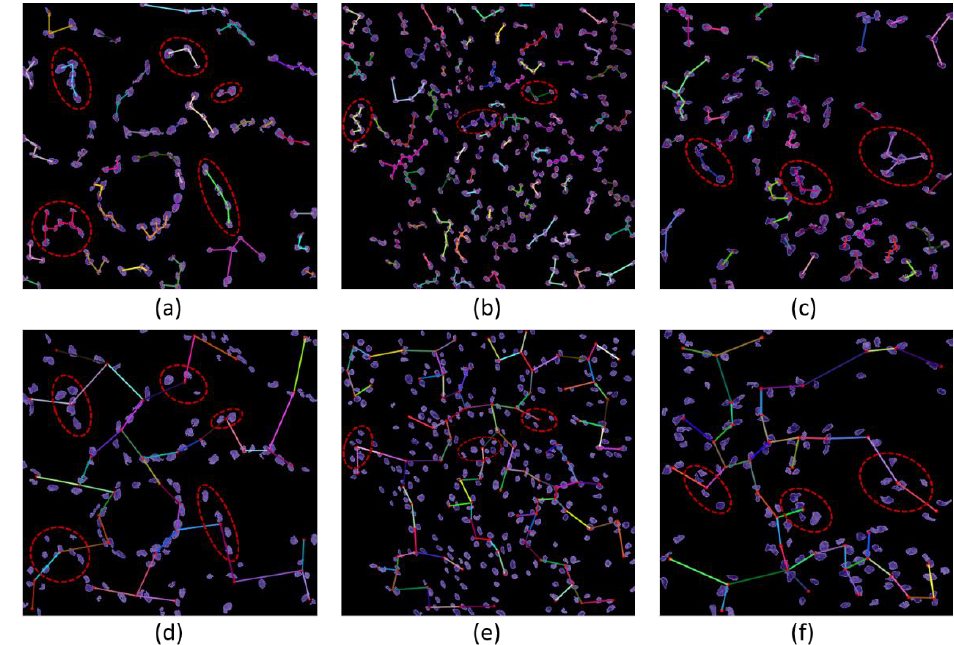
Figure 11. Bar chart of the overall performance scores of supervised and unsupervised classifica- tions.